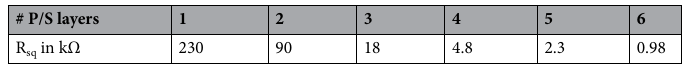
Table 2. Sheet resistance R sq versus number of PEDOT:PSS (P/S)